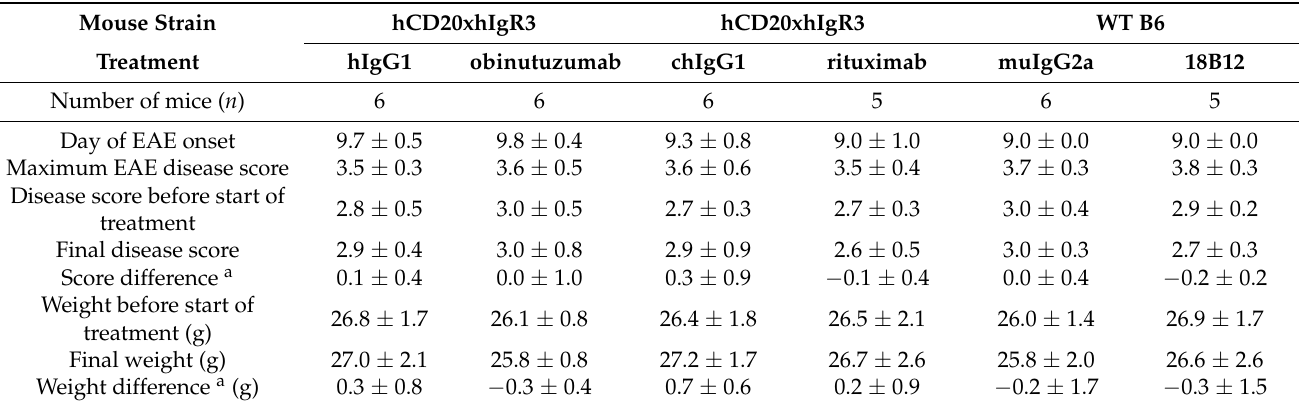
Table 1. Clinical disease characteristics in mice treated with anti-CD20